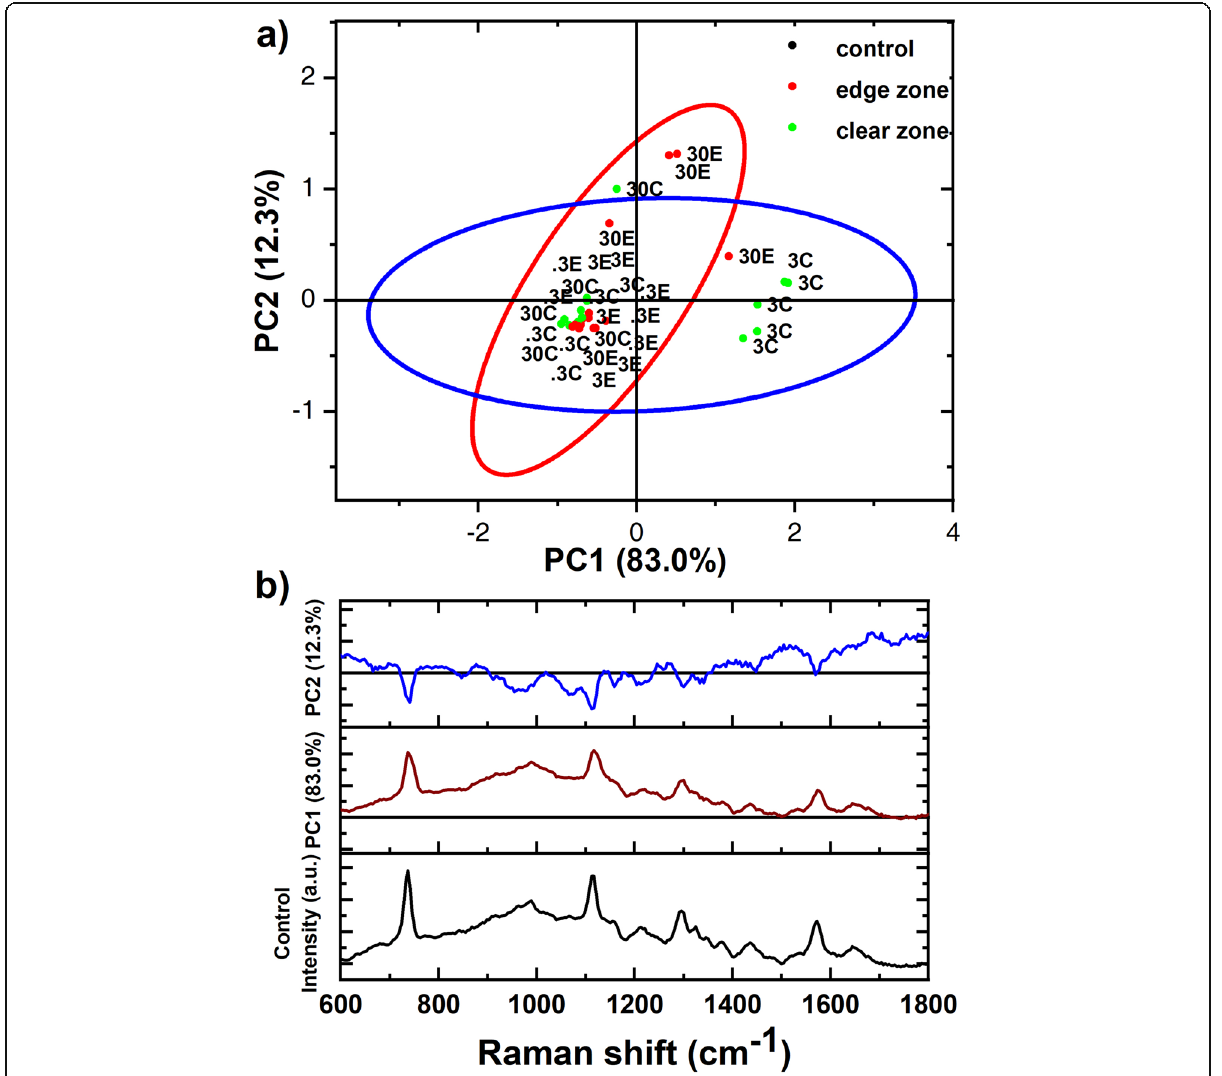
Fig. 5 PCA a score plot and b loading plot of oregano oil affected A. hydrophila . Raman data plotted for PC1 and PC2 with increasing concentrations (0.3%, 3% and 30%). Spectra were offset for